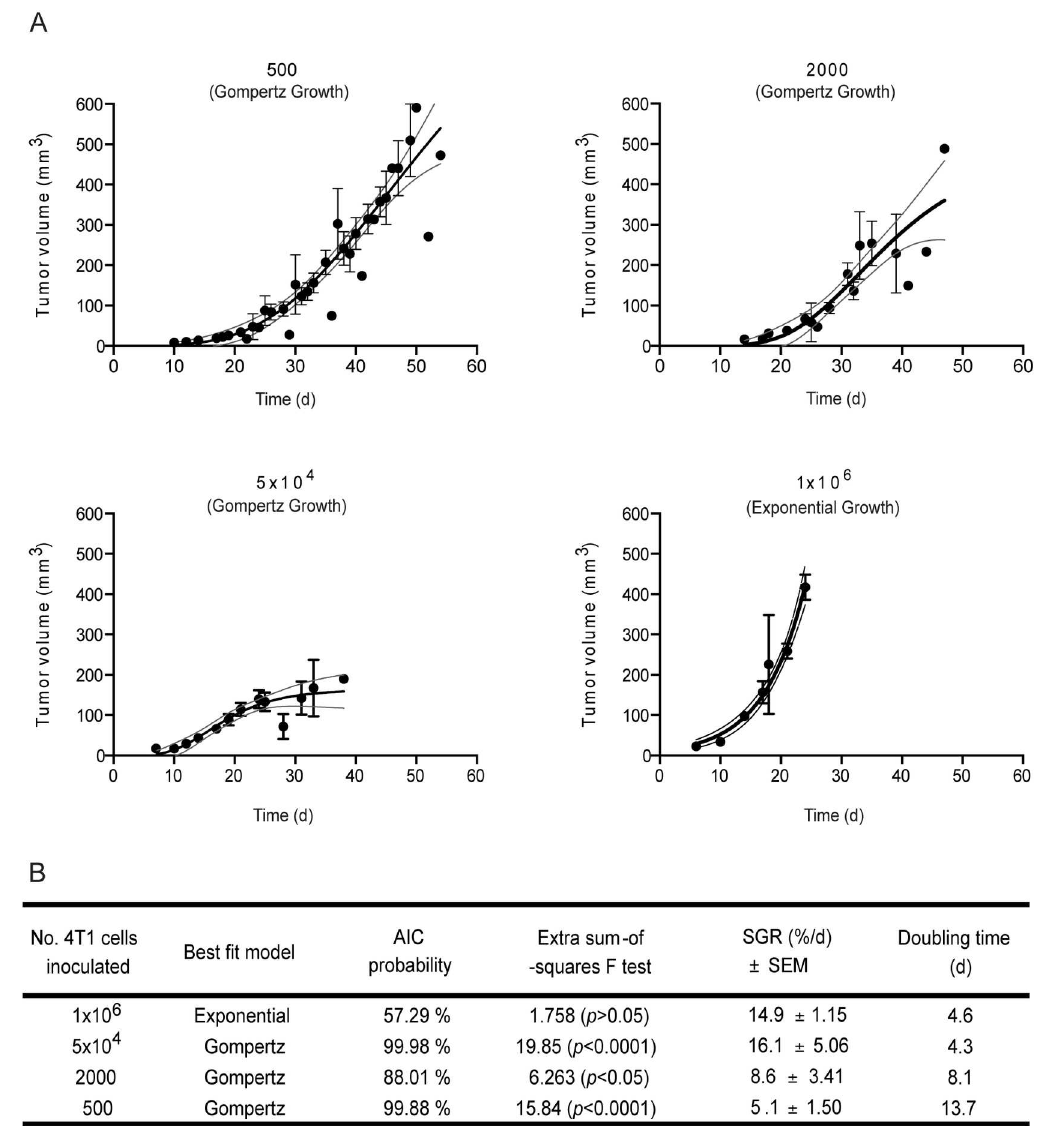
Fig 2. Fitting mathematical growth models to tumor experimental data as a function of inoculated cell density. Exponentialand Gompertz models were fitted to the population’stumor growth curves (A) and compared using the Akaike’s informationcriteria (AIC) and the extra sum-of-squares F test (B). Specific growth rates (SGR) and doublingtimes of each group were determinedfrom the mathematical equations of the best fit (B). Dark symbols represent experimental mean tumor volumes. The solid line represents the best fit for each group with a 95% confidenceinterval, light lines.